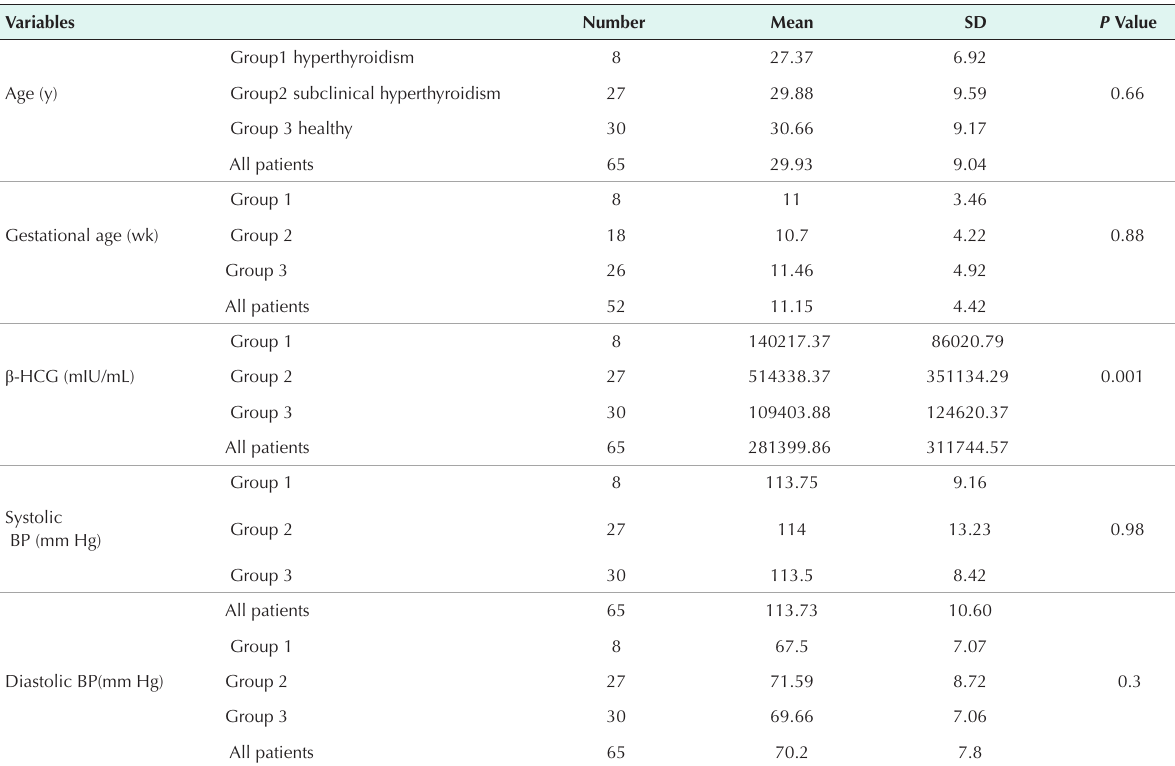
Table 1. The Relationship Between Hyperthyroidism and Variables of Age, Gestational Age, β -HCG Level, Systolic and Diastolic Blood Pressure